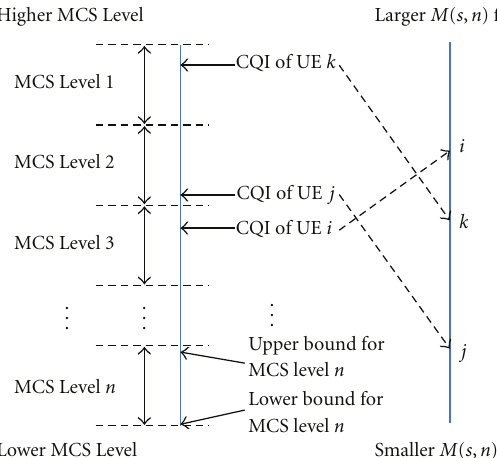
Figure 2: MCS levels and scheduling metric calculation in the proposed packet-scheduling